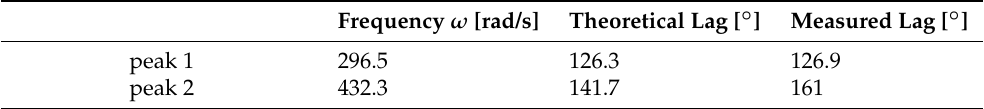
Table 3. Theoretical and measured phase lags of the two peaks highlighted in Figure